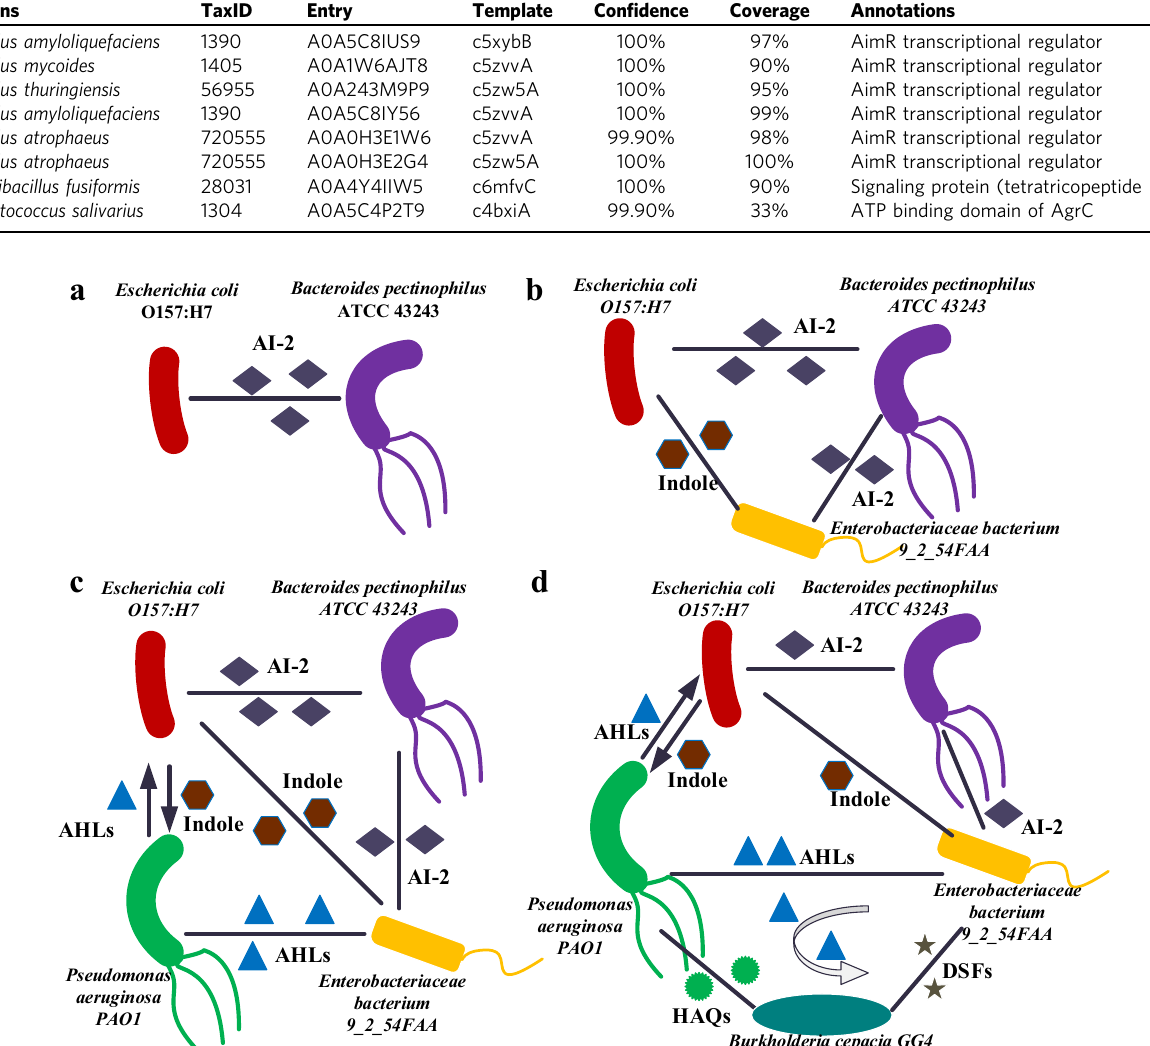
Fig. 4 QS-based communication predictions for various microbial consortium. a Two-strain communication based on AI-2; b three-strain communication based on AI-2 and indole; c four-strain communication based on AI-2, indole, and AHLs; d fi ve-strain communication based on diverse QS